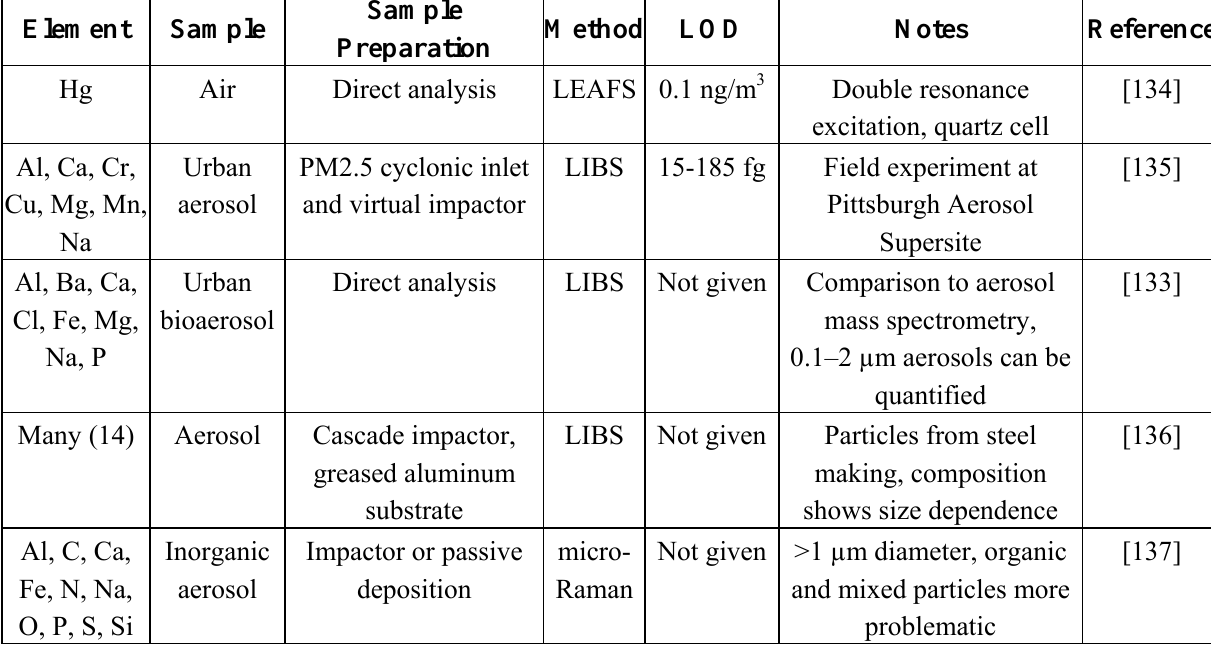
Table 3. Laser-based spectroscopic applications to environmental gases and